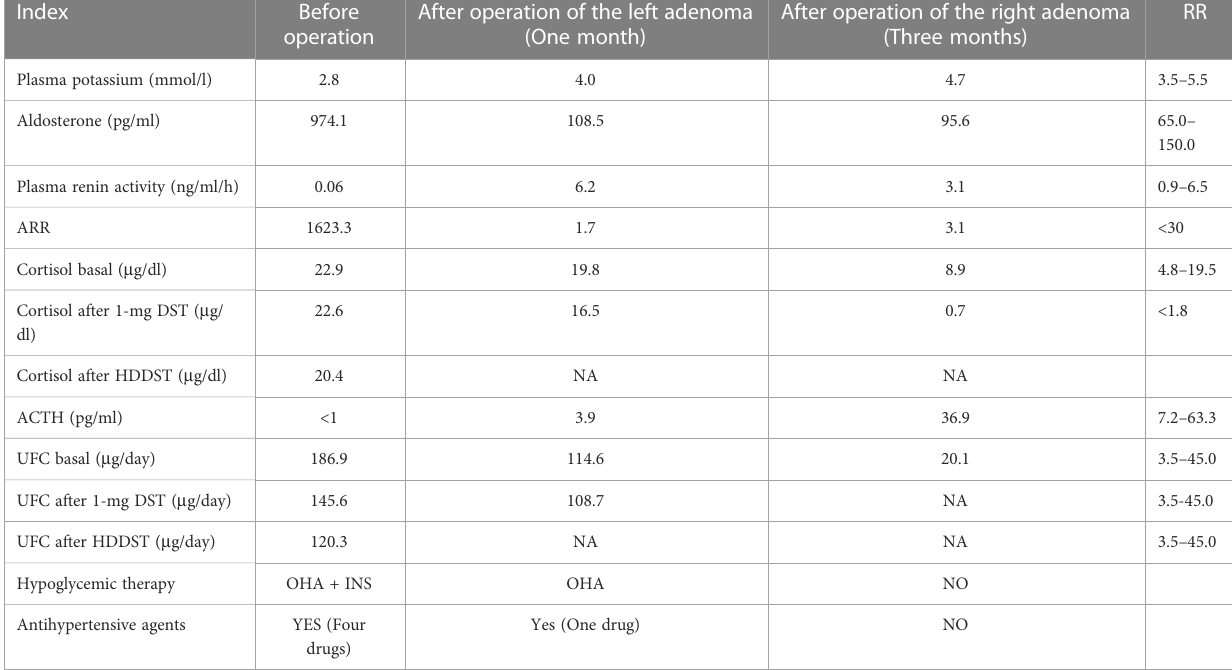
TABLE 1 Clinical data and treatments before and after